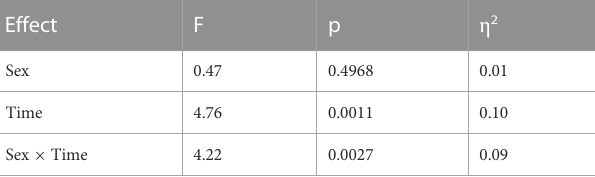
TABLE3Maineffectsandinteractioneffectsofsexandtimechangesinrelative approach ( Δ %). Two-way repeated measures